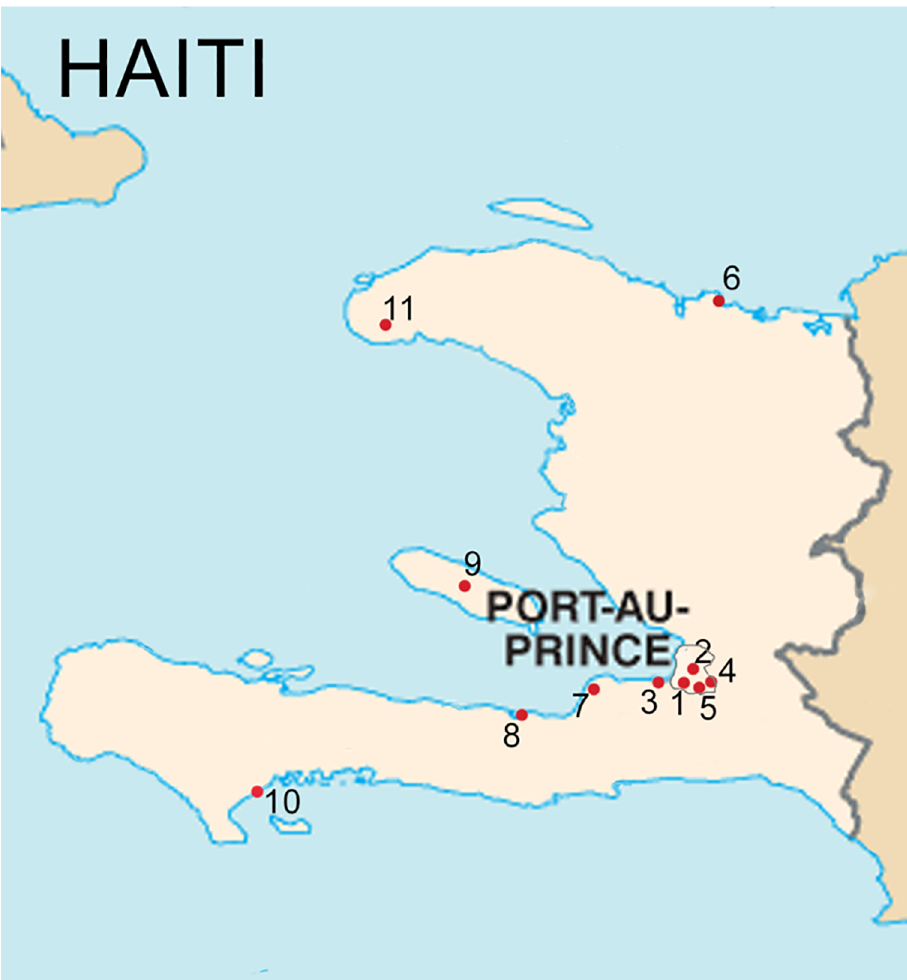
Fig 1. Map of included HIV facilities (N = 11) in